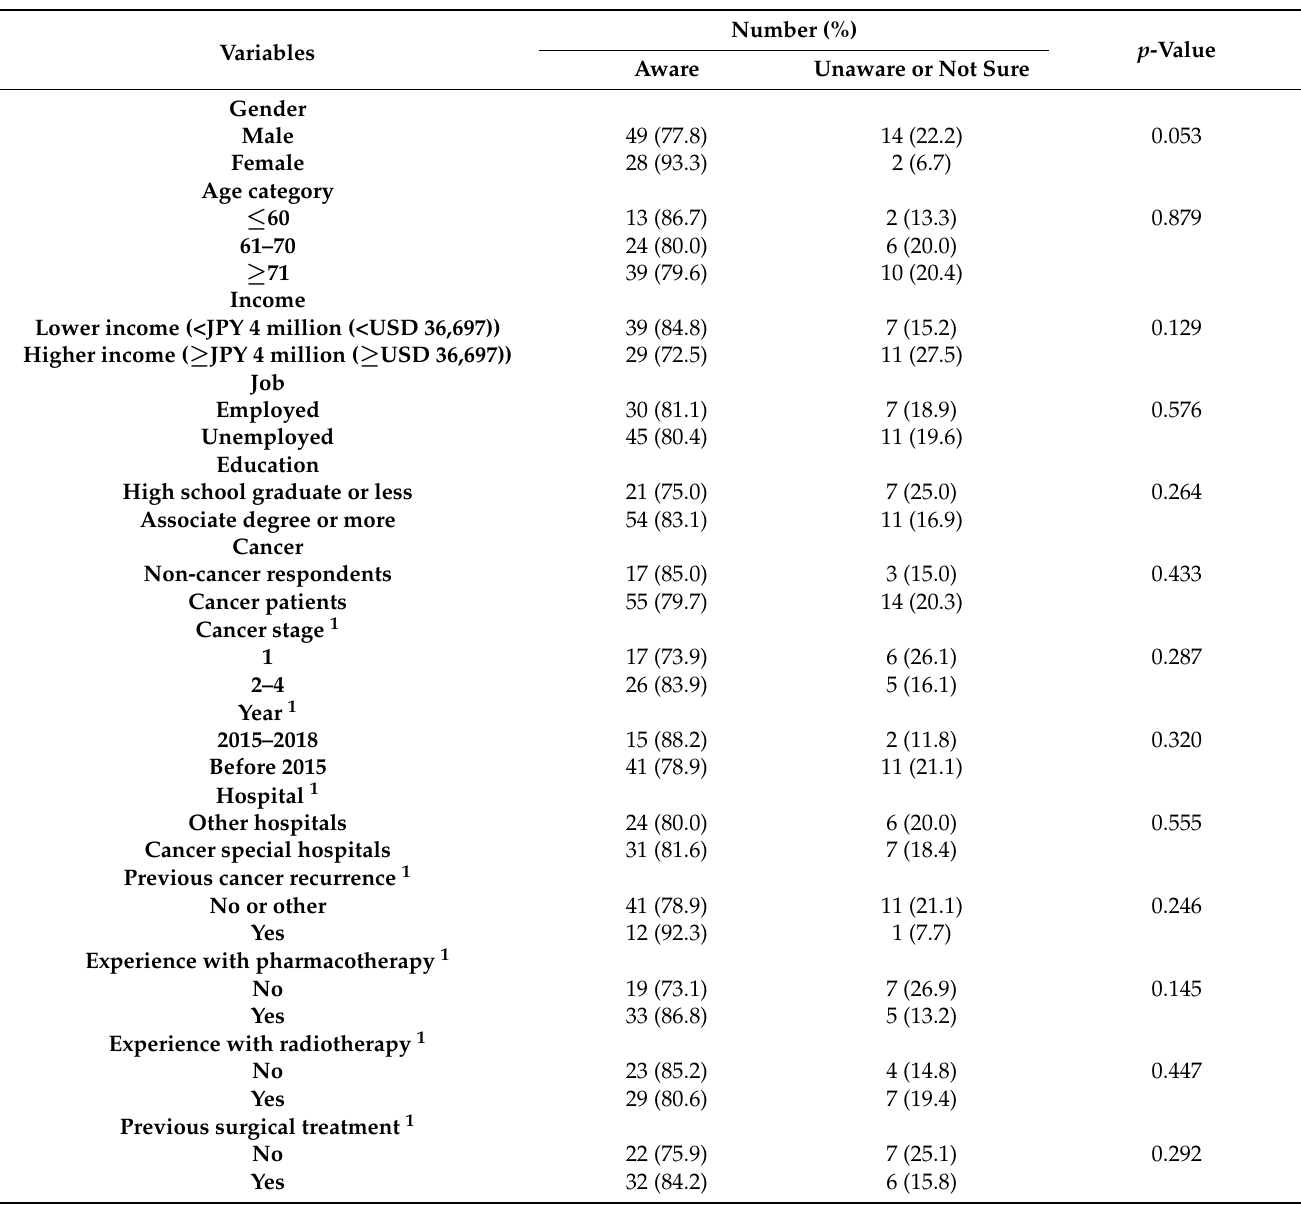
Table 2. Demographic breakdown of respondents’ awareness of at least one physician–Pharma